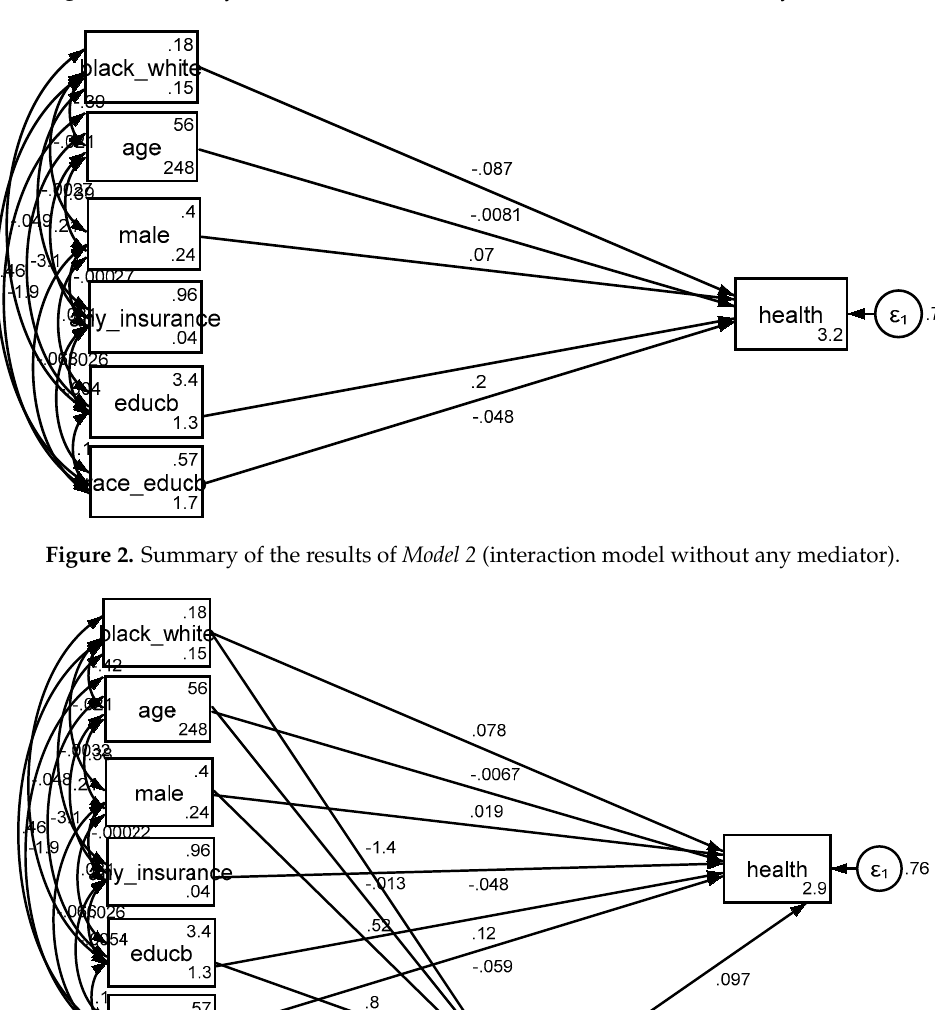
Figure 1. Summary of the results of Model 1 (main effect model without any mediator).